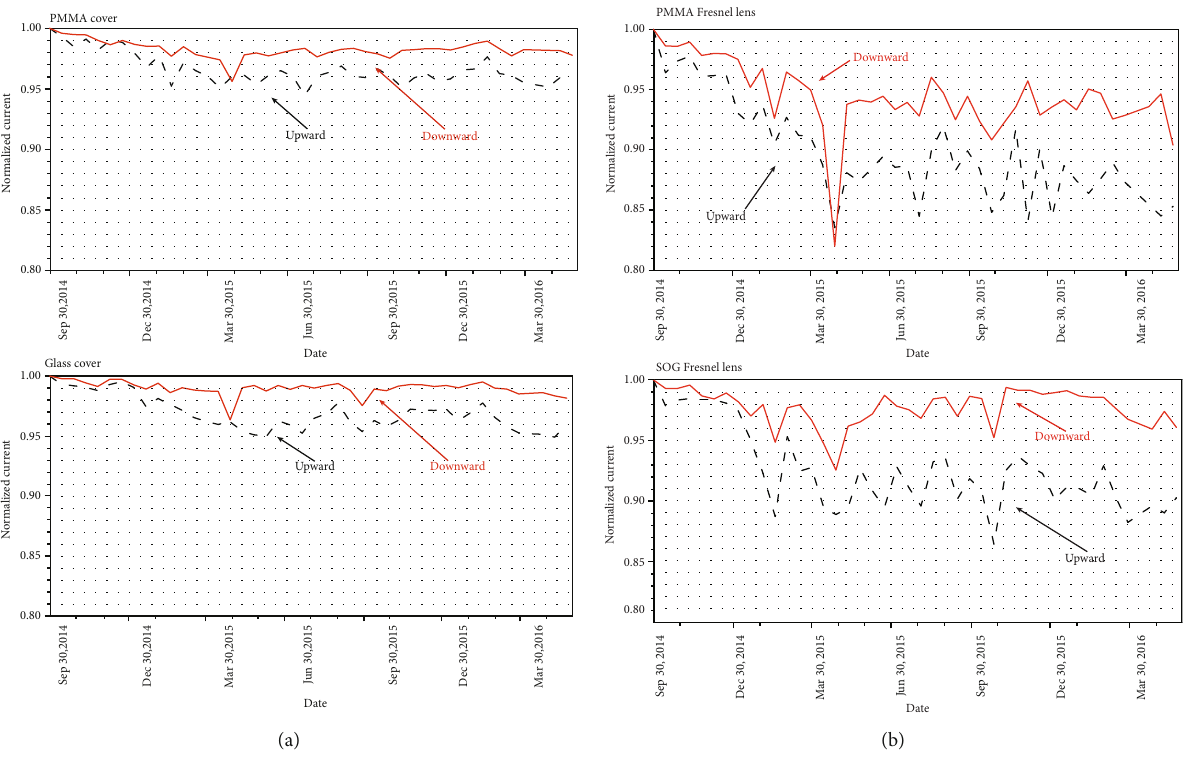
Figure 6: Changes in the calculated normalized photocurrent of the PVs using PMMA and glass surfaces on the downward and upward systems during exposure of (a) nonconcentrating Si PV and (b) CPV using InGaP/InGaAs/Ge triple-junction solar cell.